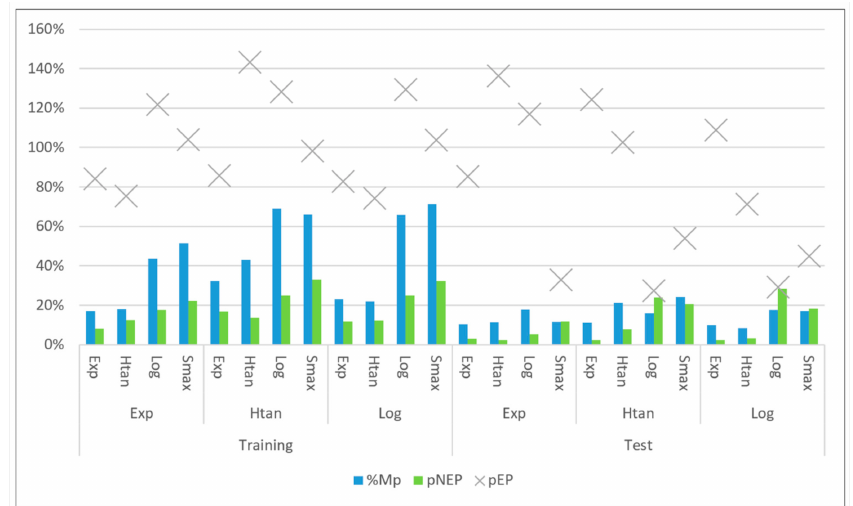
Figure 7. The values of %MP, pNEP and pEP indicators, depending on the type of activation function in the hidden layer and the output layer for the number of neurons in the range from 5 to 30.